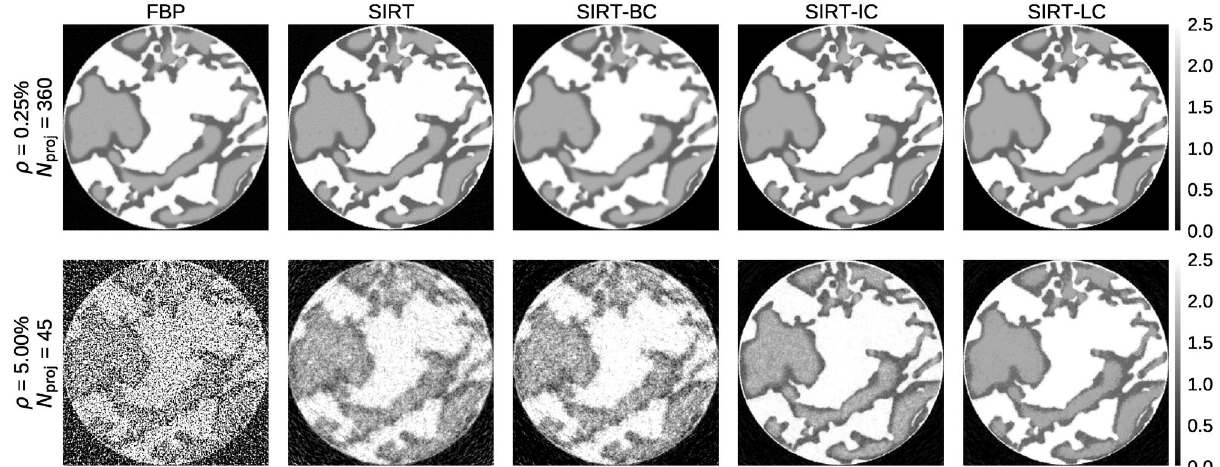
Figure 3. An example of the five different reconstruction algorithms for the best (upper row) and worst (lower row) data cases. Slice 171/256 at time step 51/100 is shown in the figure. Note that scale bar is truncated to [0, 2.5]. This makes the effect of box constraints present in SIRT-BC, SIRT-IC and SIRT-LC less pronounced.